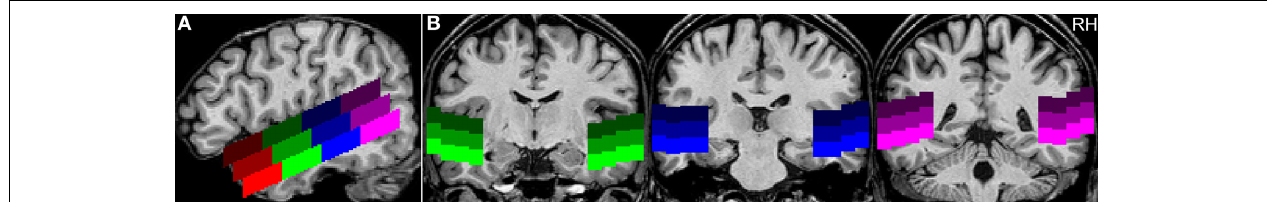
FIGURE 2 | Example for the positioning of the regions of interest. (A) The sagittal view of a single subject’s brain shows the position of the ROIs along the superior temporal sulcus at Talairach coordinate x = 50 (RH, right hemisphere). The upper row of ROIs covers the superior part of the STG (sSTG), the middle row the inferior part of the STG (iSTG), and the lower